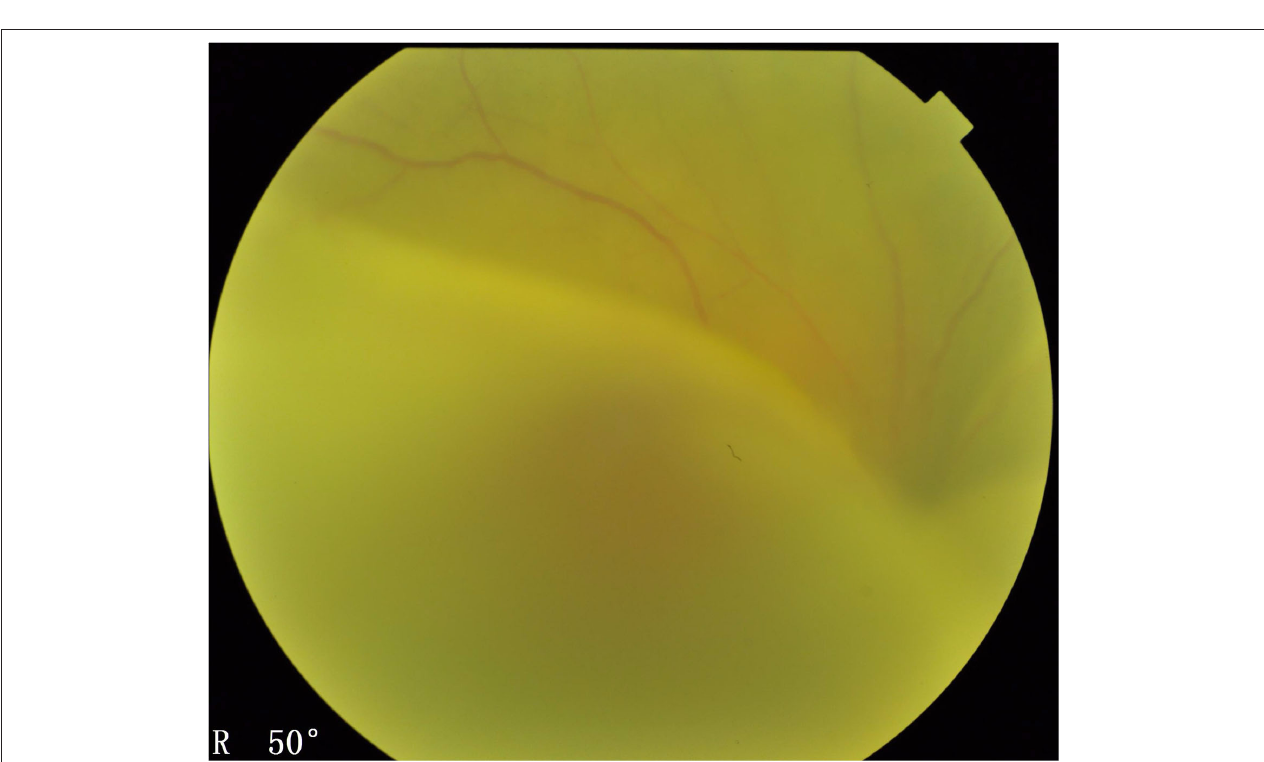
FIGURE 5 | Type 2 UES. The fundus examination (Imagenet 6, Topcon, Japan) demonstrated typical manifestations of exudative bullous retinal detachment associated with ciliochoroidal detachment similar to those observed in type 1, except that there was no papilledema.